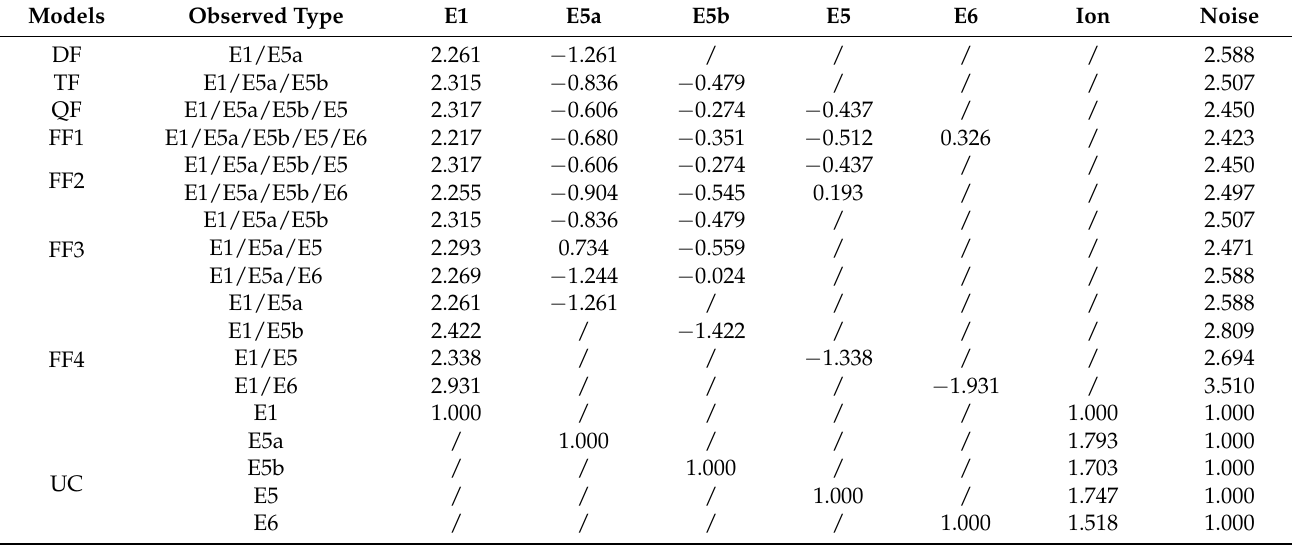
Table 1. Summarization of Galileo DF, TF, QF and FF PPP